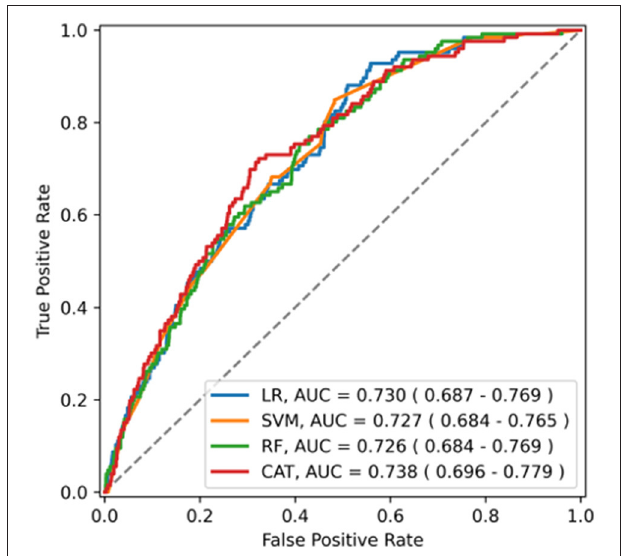
FIGURE 2 | The receiver operating characteristics curve of the model for central dizziness. LR, logistic regression; SVM, support vector machine; RF, random forest; CAT, Catboost; AUC, area under the receiver operating characteristic curve.